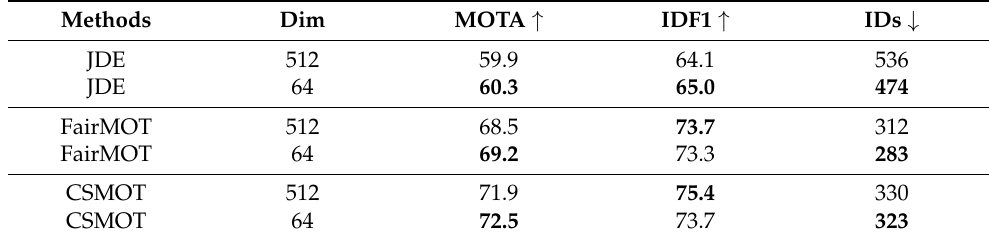
Table 4. Evaluation of the re-ID feature dimensions of JDE, FairMOT, and CSMOT. The best results of the same method are shown in bold .